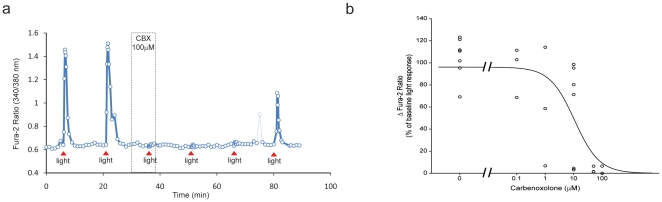
Light-evoked Ca2+ responses in ipRGCs in the absence and presence of carbenoxolone.(a) The light-evoked elevation in [Ca2+]i in an isolated ipRGC was completely blocked in the presence of 100 µM carbenoxolone (CBX) with only partial recovery after the third light pulse presented after 45 min of wash out. (b) Dose-response data illustrating inhibition of baseline light-evoked Ca2+ response in the presence of 0.1, 1, 10, 50 and 100 µM carbenoxolone. Only ipRGCs showing at least partial recovery after carbenoxolone washout are included. The light-evoked Ca2+ responses from seven ipRGCs in the absence of carbenoxolone (0 µM) are included. These cells gave four consecutive light-evoked Ca2+ responses (values provided are the third light-evoked Ca2+ response compared to preceding light-evoked Ca2+ response as baseline). The curve was fit with a three-parameter logistic equation (EC50 = 11 µM). Non-evoked elevations in [Ca2+]i in isolated ipRGCs, due to spontaneous action potential firing, are de-emphasized by plotting data with lightened dashed lines.